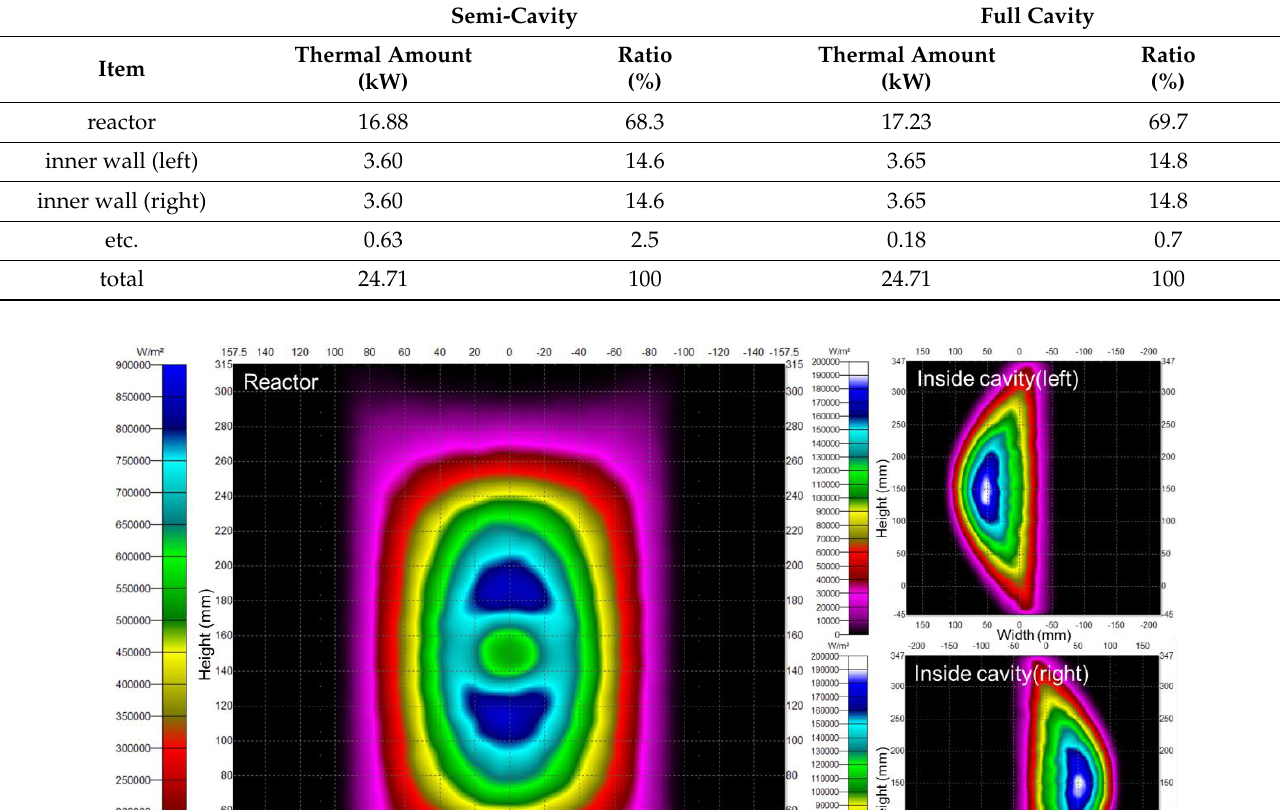
Table 3. Concentrated heat amounts according to location in the cavity. Semi-cavity